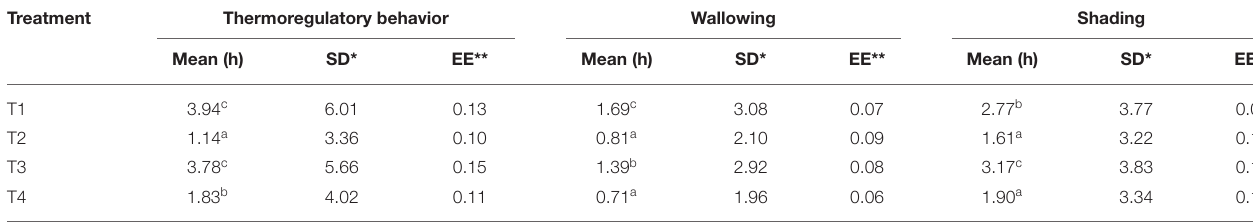
TABLE 5 | Time spent in thermoregulatory behavior, wallowing and shading. Treatment